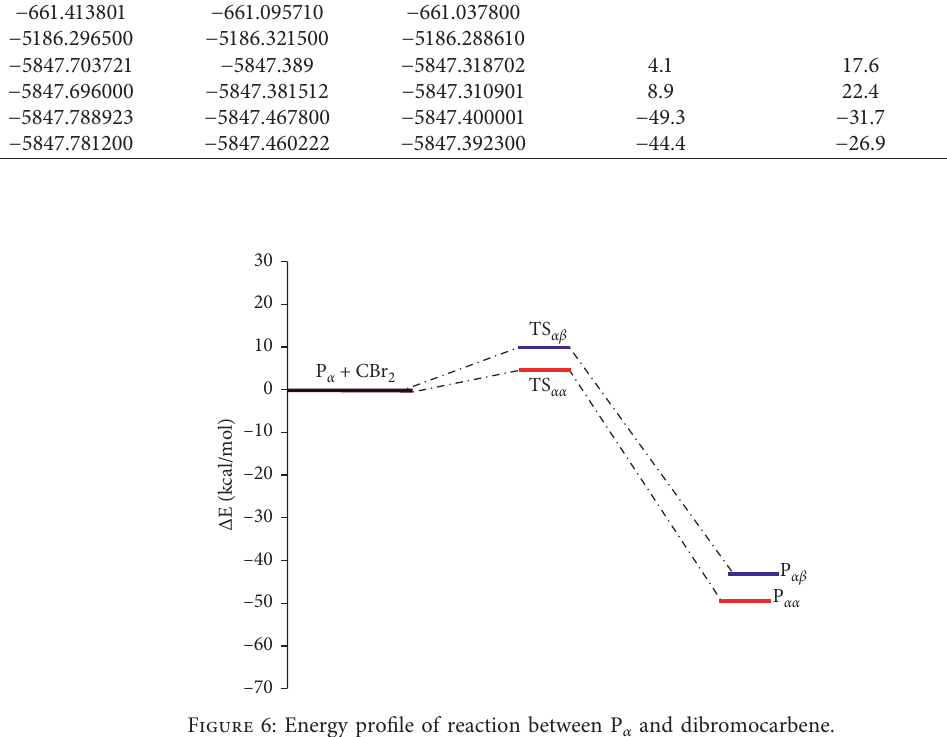
Table 5: Thermodynamic energies of the cyclopropanation reaction between P B3LYP/6-311 +G (d, p) basis set.